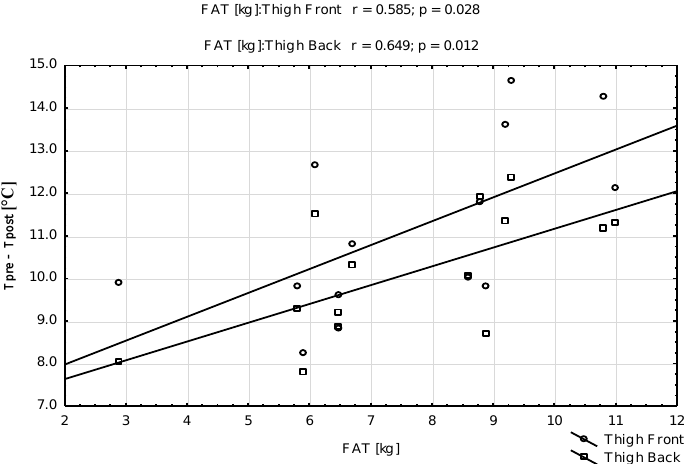
Figure 5. Relationship between body fat content and the magnitude of change in temperature of the anterior and posterior surfaces of the thighs.